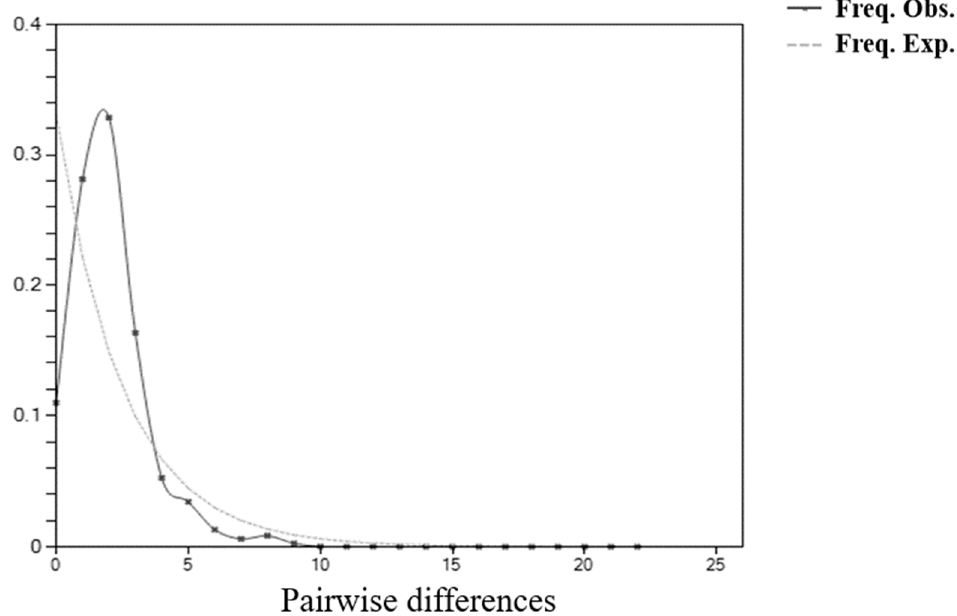
Figure 2. Mismatch distribution of frequencies of the pairwise number of differences among Merops apiaster populations. The dotted line represents the observed values in a stable population with a constant population size. The solid line represents the observed frequency of the pairwise mismatch distribution of mtDNA.